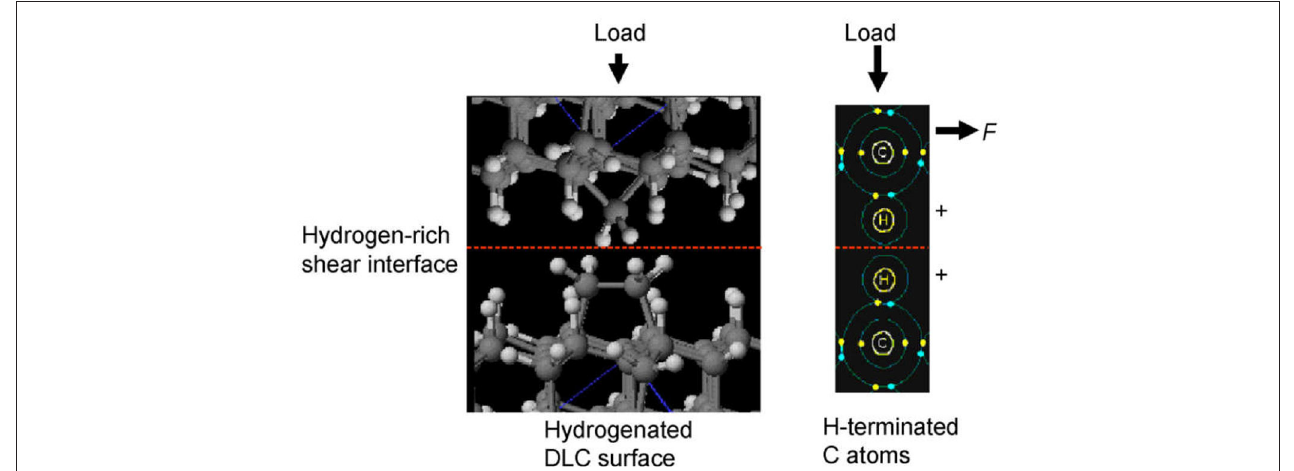
FIGURE 3 | Schematic of hydrogen-passivated none-adhesive sliding surface. Adapted with permission from Erdemir (2001) Copyright 2001, Elsevier Science B.V.